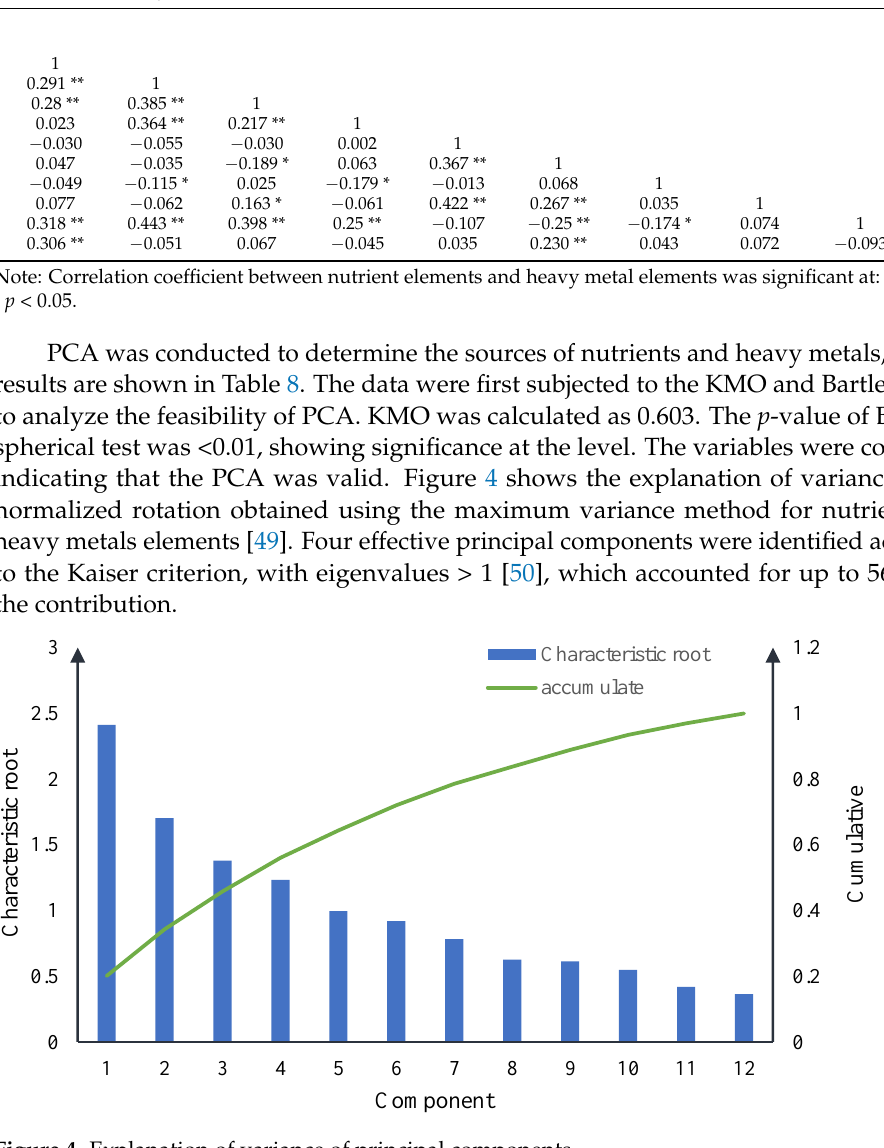
Figure 4. Explanation of variance of principal components.